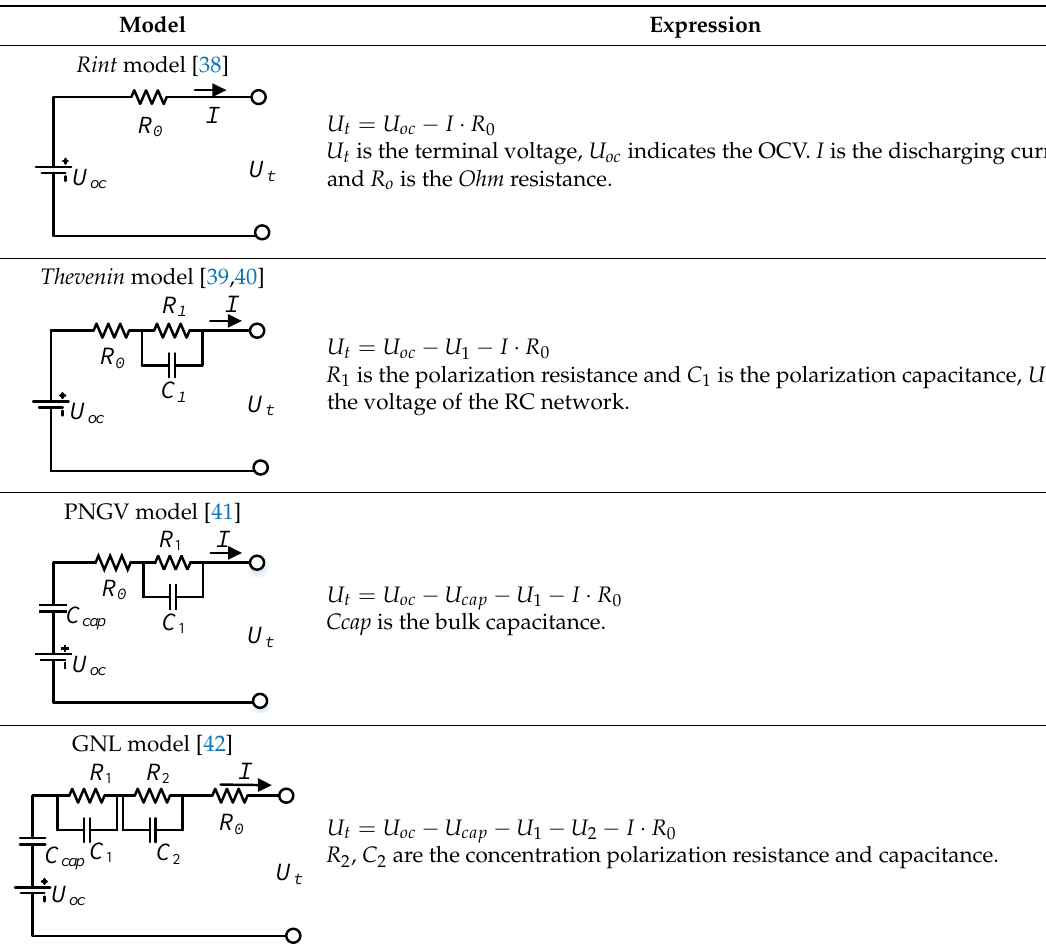
Table 3. The expressions of the four common ECMs.